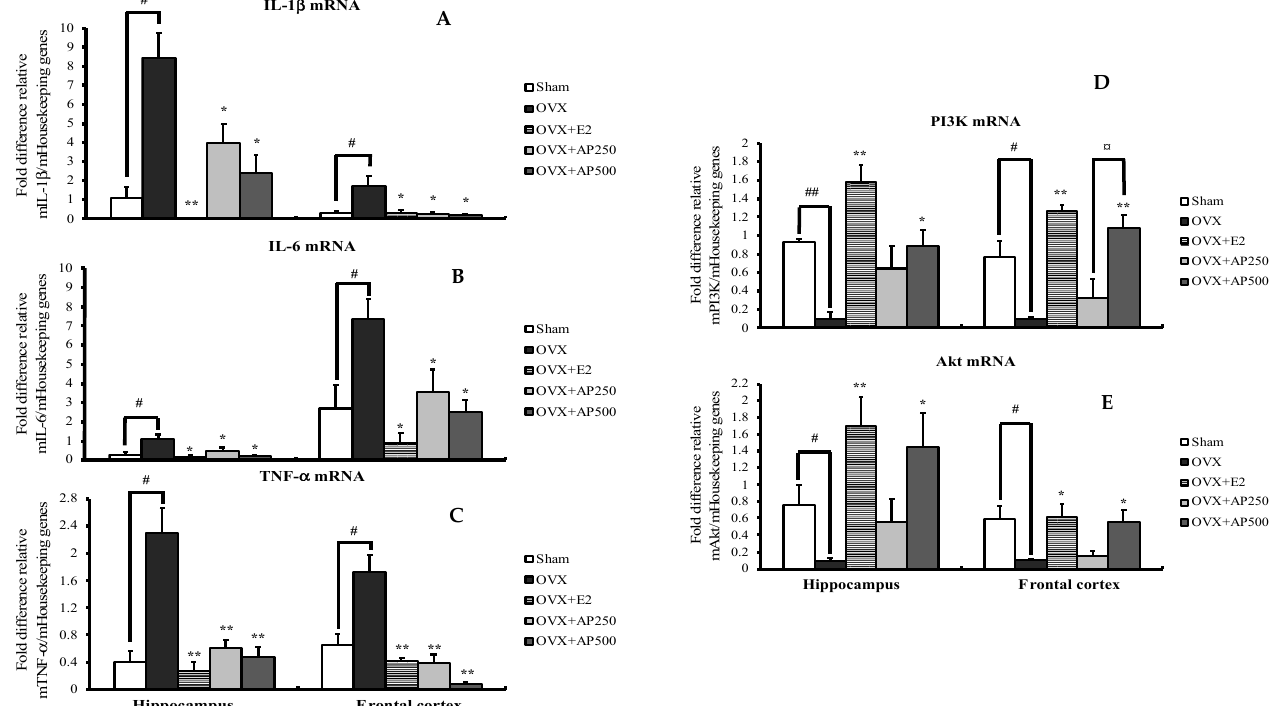
Figure 4. Effect of the AP extract on pro-inflammatory cytokines-related genes ( A – C ) and PI3K/AKT pathway-related genes ( D – E ) in mRNA expressions of mice hippocampus and frontal cortex. Each column represents the mean ± SEM (n = 5–8). ## p < 0.001 vs. the sham-operated group, # p < 0.001 vs. the sham-operated group and * p < 0.05, ** p < 0.001 vs. the OVX group and ¤ p < 0.001 vs. the AP extract (post hoc Tukey test).